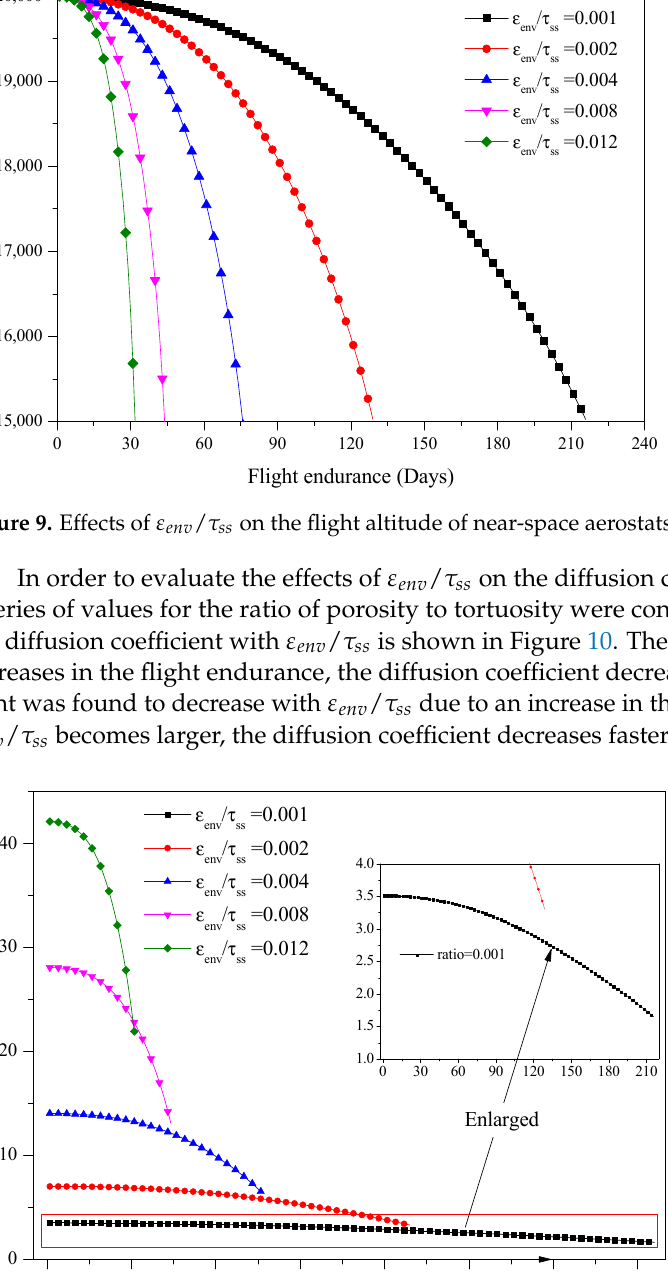
ε τ / Figure 11. Effects of on the ( a ) maximum skin temperature per day, ( b ) maximum gas env ss temperature per day, ( c ) maximum gas pressure per day, and ( d ) maximum gas pressure differ- ence per day.